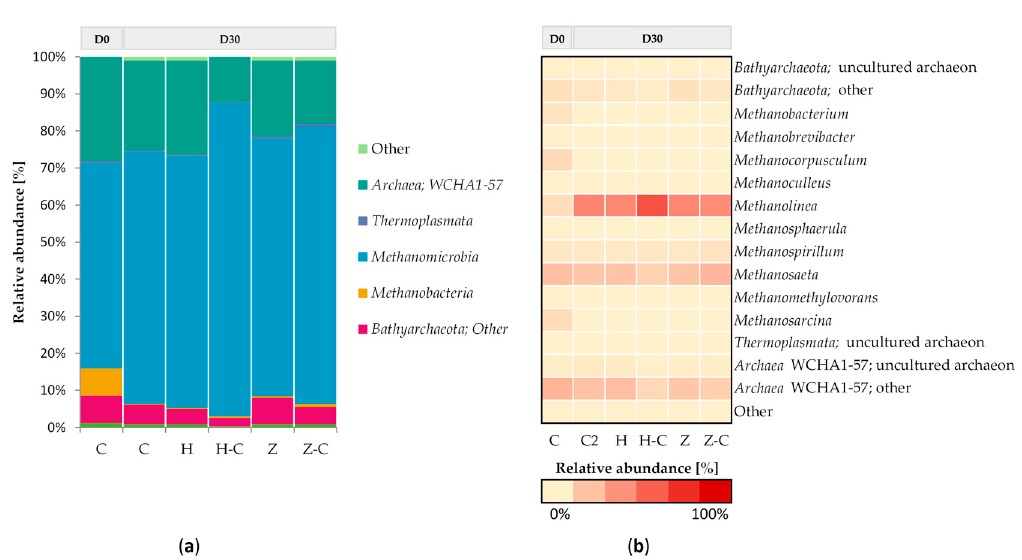
Figure 3. Relative abundance of archaeal OTUs: ( a ) archaeal classes and ( b ) archaeal genera with an abundance > 1% in at least one variant are shown. C: control; H: halloysite; H-C: halloysite- colonisation; Z: zeolite; Z-C: zeolite-colonisation; D0: Day 0; D30: Day 30.